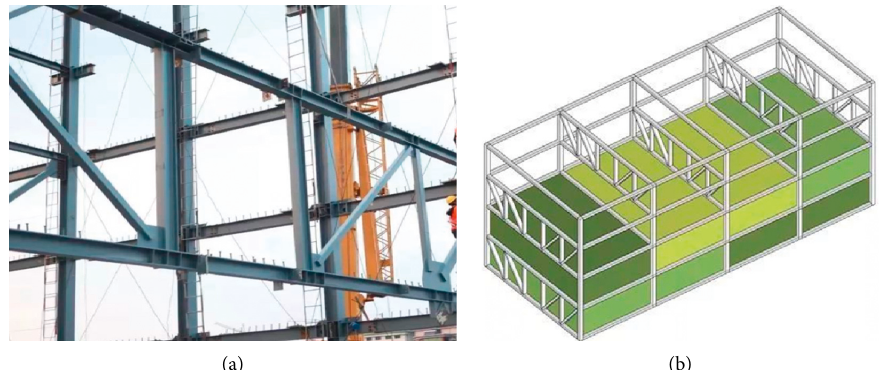
Figure 1: Staggered truss steel structure. (a) The staggered truss steel structure in reality; (b) a 3D model of the staggered truss steel